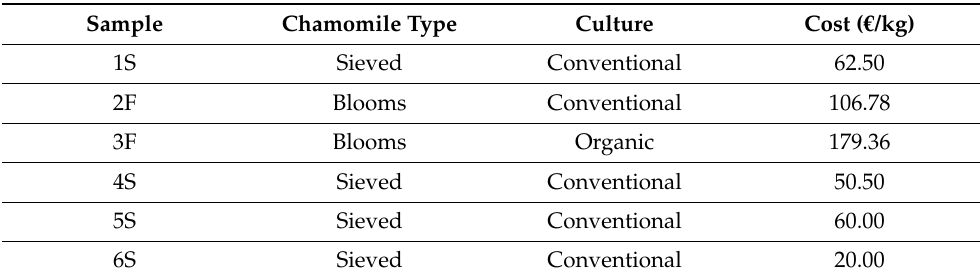
Table 3. Description of chamomile samples analyzed in the